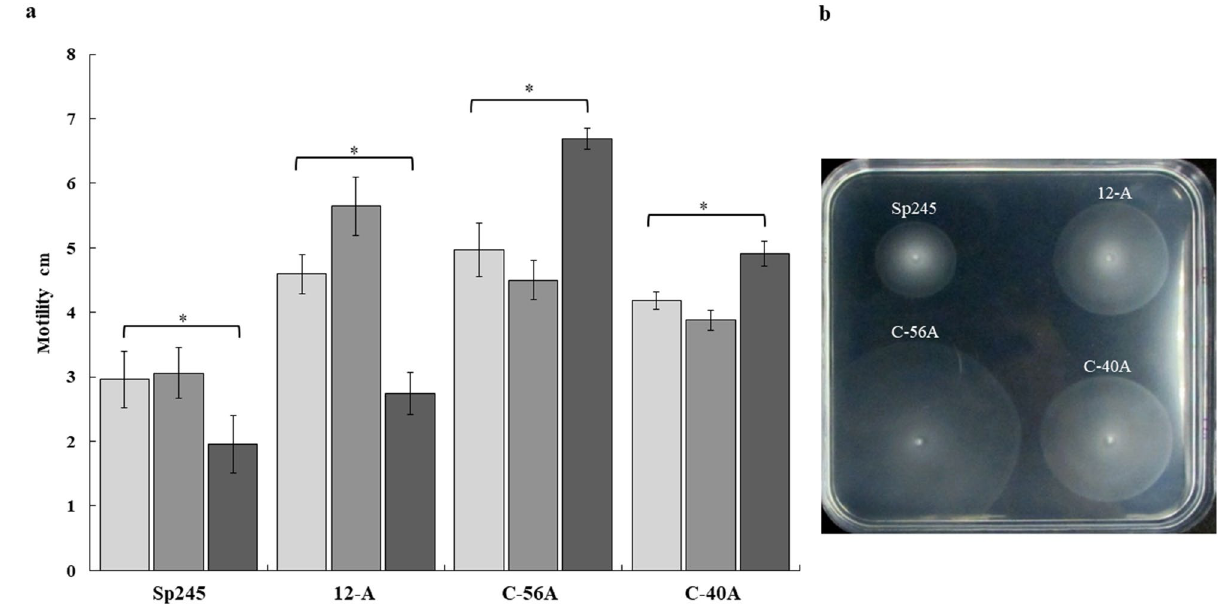
Figure 3. Effects of the mutation and overexpression of the cdgD gene on motility determined in A. brasilense WT and derivative strains. ( a ) The diameter of the swimming rings in the mutant and the complemented mutant relative to the wild-type strain was measured in minimal medium with the tested carbon sources at 10 mM after 48 h of incubation at 30 °C ( malate, fumarate, or proline). Error bars represent the standard deviations of three biological replicates, and the asterisks indicate values that are significantly different from those in the wild type ( P < 0.05) according to Student’s T test by SigmaPlot (Systat Software, San Jose, CA). ( b ) Photograph of a typical agar plate containing minimal medium with 10 mM proline as the carbon source showing the swimming rings of each strain. Wild type (Sp245), isogenic mutant (12-A), complemented mutant (C-56A), and empty vector mutant